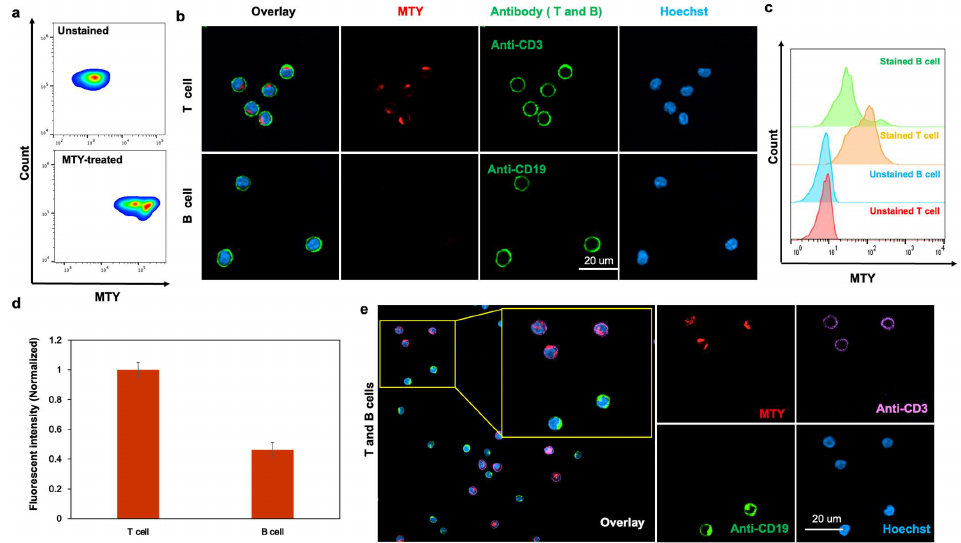
Figure 2. Selectivity of MTY in human T and B cells. ( a ) MTY performance in the lymphocyte of blood. The WBCs were incubated with MTY (1 μM) for 1 h. ( b , c ) Selectivity in isolated human T and B cells. T cells were colocalized with MTY and CD3 antibody. B cells were colocalized with MTY and CD19 antibody. Fluorescence images ( b ) and flow cytometry ( c ) were taken after 1 h incubation with MTY (100 nM) and 30 min with antibody. ( d ) Quantitative comparison of fluorescent intensity by flow cytometry. Fluorescent intensity in Figure 3c was normalized and represented as histogram. ( e ) Selectivity of MTY in mixed T and B cells. T cells and B cells were randomly mixed, and then treated with MTY (100 nM), Hoechst (1 μg/mL), CD3 antibody and CD19 antibody.